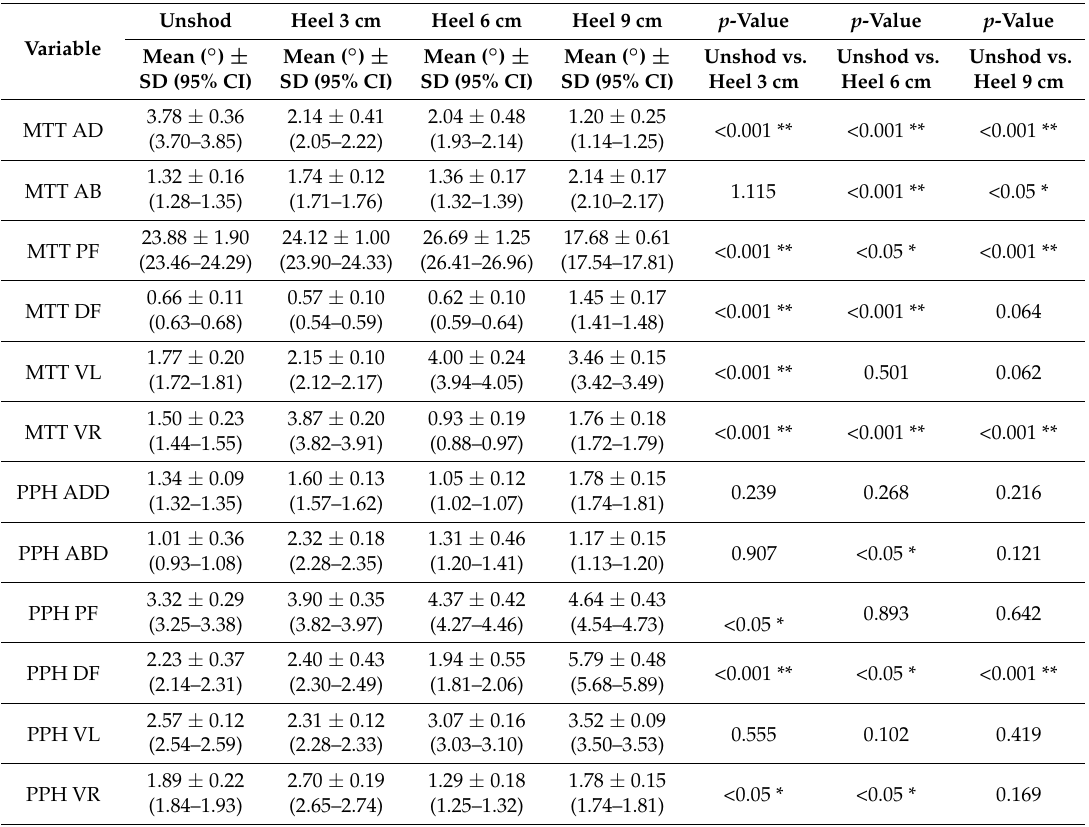
Table 4. STATIC mobility grades of first metatarsal (sensor 1) and proximal phalanx of hallux (sensor 2) bones in unshod with heels of 3 cm, 6 cm, and 9 cm